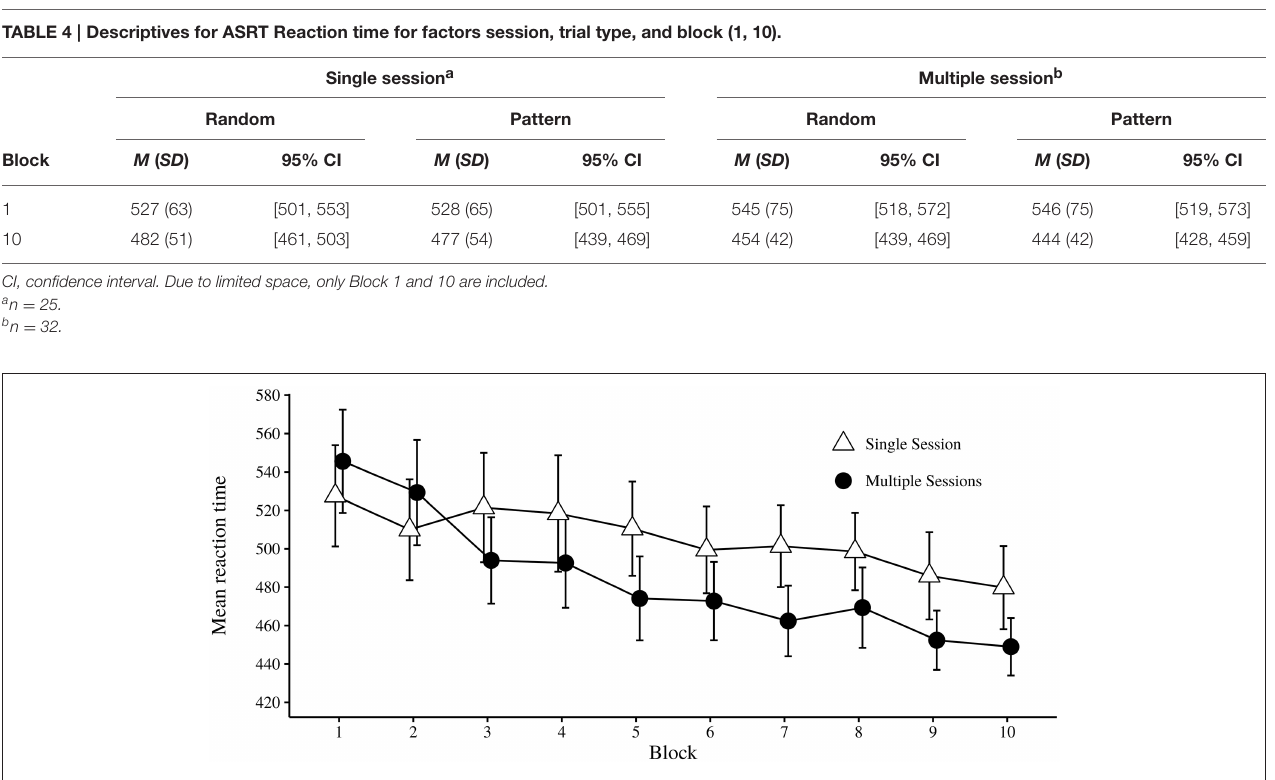
FIGURE 5 | Mean of median reaction time in milliseconds over each block, divided by single and multiple sessions conditions. Error bars indicate 95%